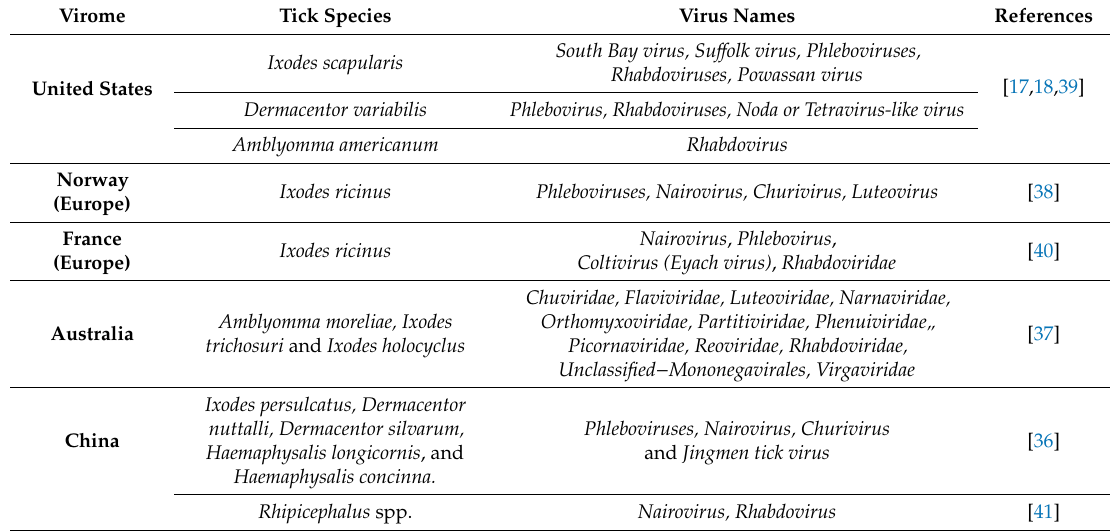
Table 1. At-a-glance view of the global tick